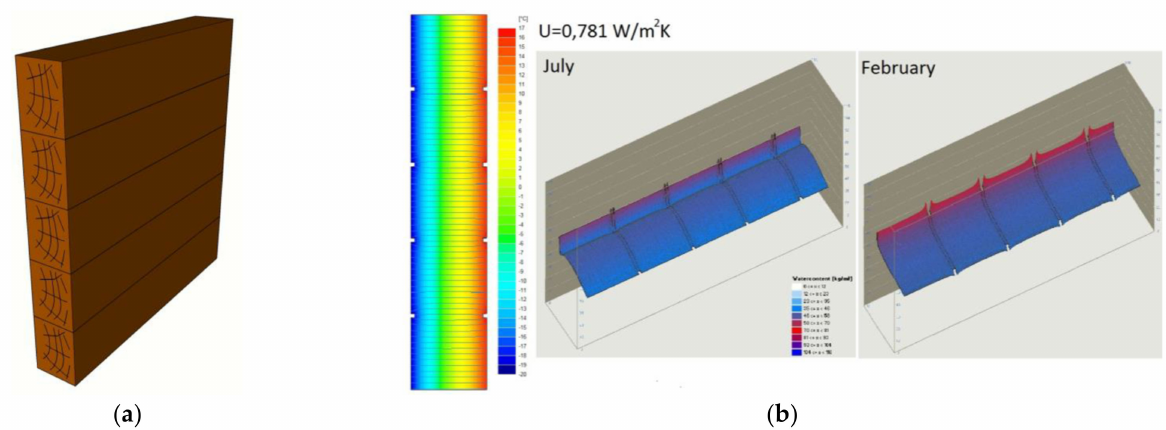
Figure 22. Results of simulation calculations for an average wall made of wooden logs: ( a ) isotherms of temperature distribution from − 20 ◦ C on the external side to +20 ◦ C on the internal side, ( b ) humidity distribution on the wall in summer and